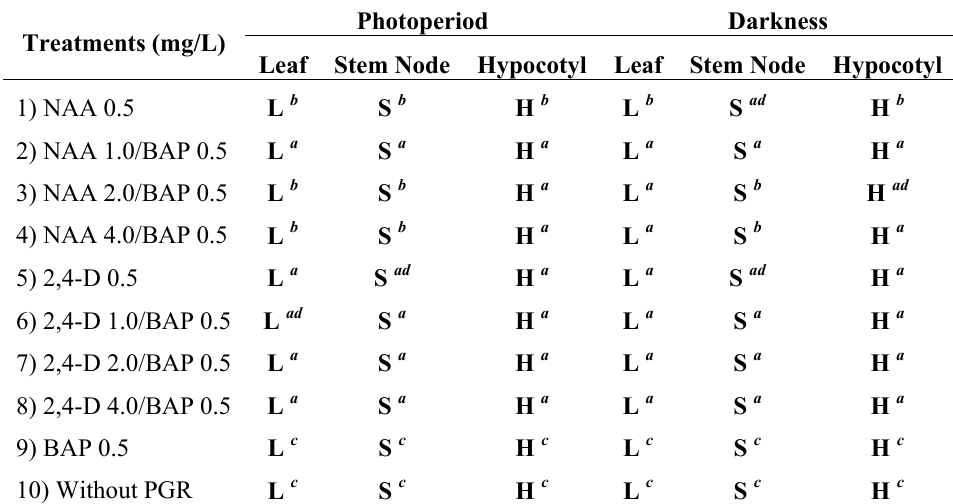
Table 2. Callus formation response in different combinations of plant growth regulators, explants, and incubation conditions that resulted in thirty seven different lines of Lopezia racemosa Cav. calli after thirty days of culture. Photoperiod Darkness Treatments (mg/L) Leaf Stem Node Hypocotyl Leaf Stem Node Hypocotyl